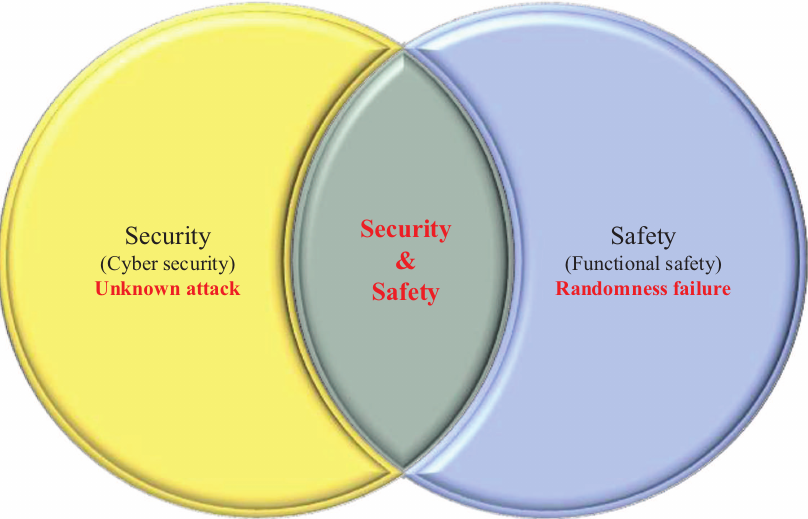
Figure 1. Security & Safety integration